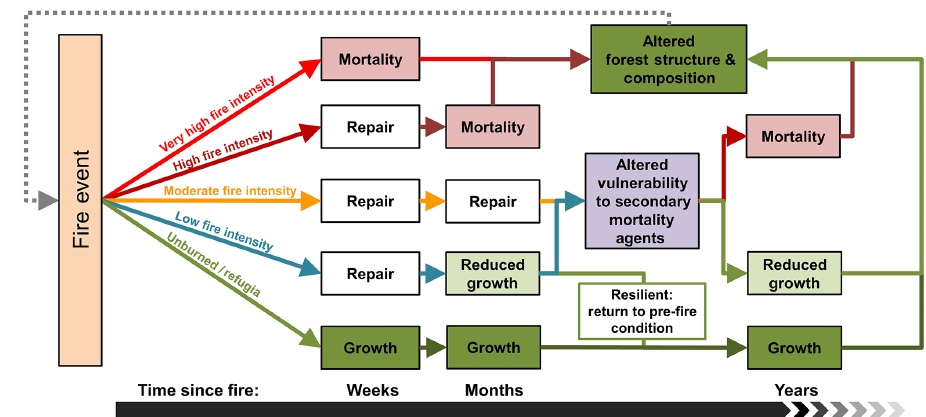
Figure 5. Conceptual framework for quantifying impacts of fire intensity on physiology, growth, and vulnerability of coniferous forests.